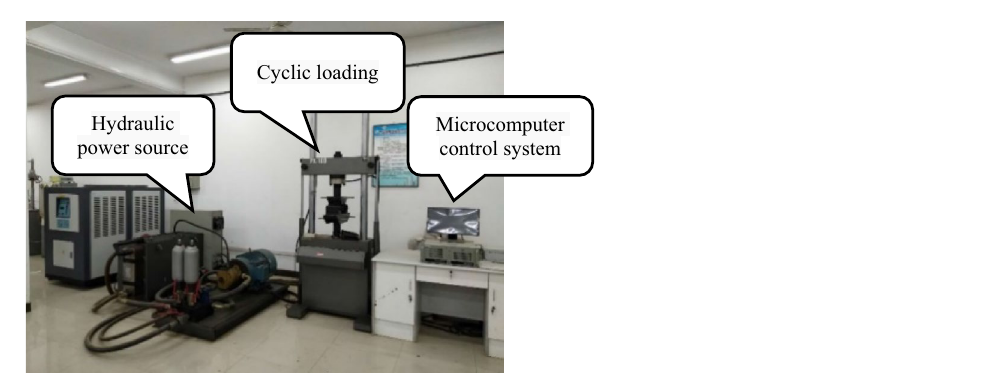
Figure 4. Testing